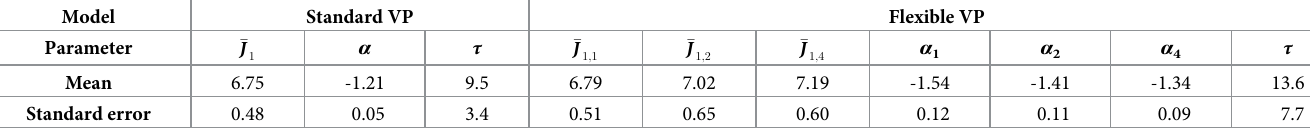
Table 1. Maximum-likelihood parameters of the two models fitted to the data of Experiment